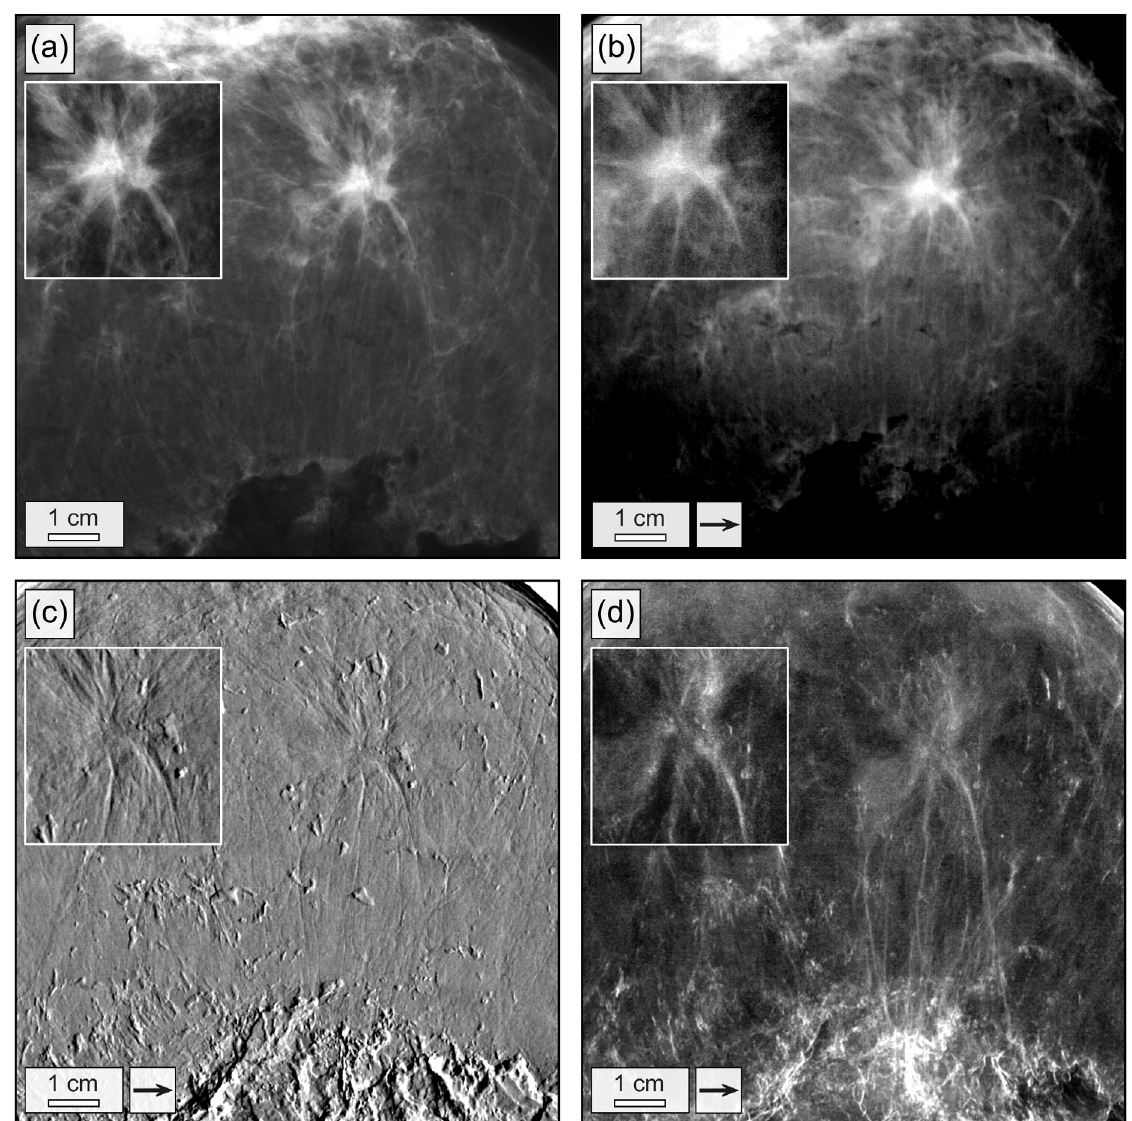
Figure 2. Conventional and grating-based mammograms of a breast specimen with invasive ductal carcinoma. Conventional mammogram (a), grating-based absorption (b), differential phase (c) and dark-field image (d) of the breast specimen. The field of view has a size of 12.8 6 12.8 cm 2 . Images (b)–(d) were obtained by stitching together 4 6 4 low-statistic projections. Arrows indicate the direction of scanning. The high- statistic images of the invasive ductal carcinoma are shown as